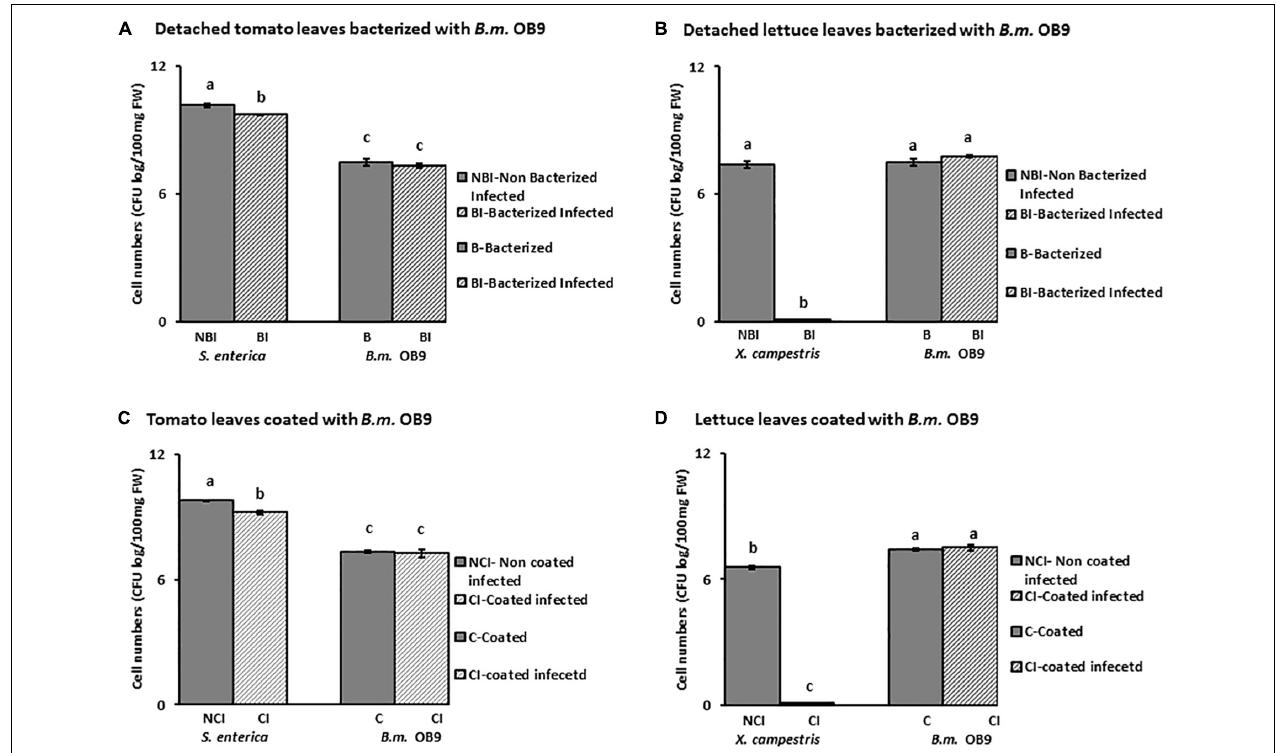
FIGURE 7 | Quantification of cell numbers of B. methylotrophicus OB9, S. enterica Newport SL1 and X. campestris B07.007 recovered from leaf tissues. Leaf tissues from bacterized with B. methylotrophicus ( B.m .OB9) and challenged with S. enterica Newport SLI and X. campestris are represented in (A,B) , respectively. Tomato and lettuce leaf samples that were coated with OB9 and infected with S. enterica Newport SLI and X. campestris are denoted by (C,D) , respectively. (BI) and (CI) samples represent B. methylotrophicus OB9 bacterized (BI) or coated (CI) tissues that are infected with either S. enterica Newport SLI or X. campestris (NBI) and (NCI) treatments represent non-bacterized and non-coated but infected with S. enterica Newport SLI or X. campestris controls, respectively. Data represent the average of 5 replicates per